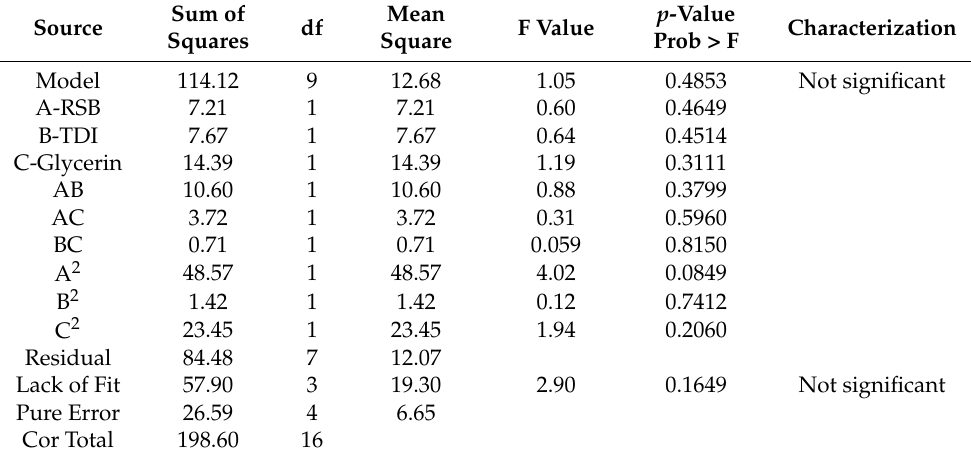
Table 4. ANOVA analysis for a quadratic model of the flux and rejection